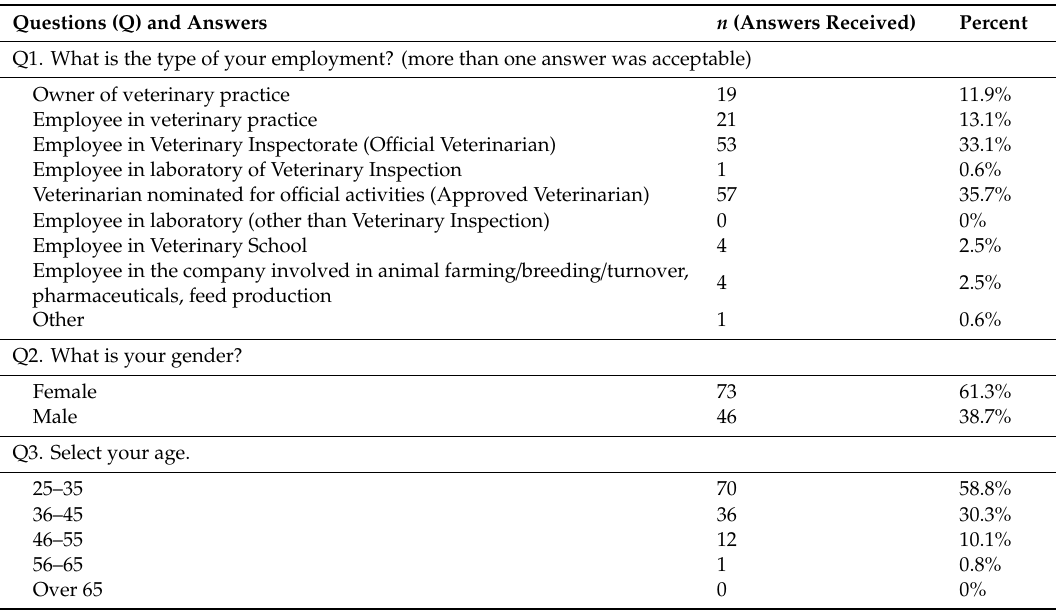
Table 1. Demographic features of veterinarians attending postgraduate courses in “Hygiene of slaughter animals, meat and animal origin